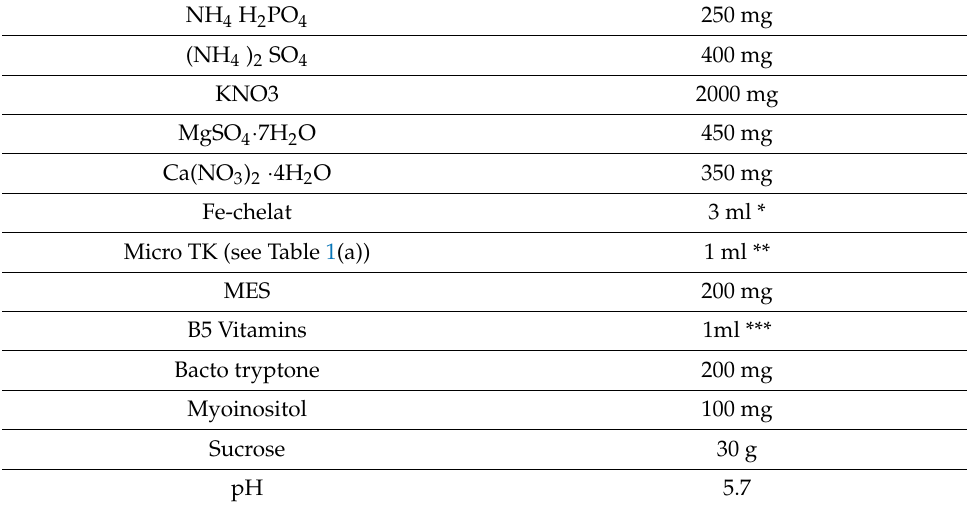
Figure 6. Cell proliferation from root-derived Arabidopsis protoplasts. ( A )—in enzyme solution; ( A1 )—in the medium after isolation; ( B ) — first cell division; ( C1 , C2 )—marker line H2B::YFP undergo mitosis. Scale bar— 20 µ m. Table 3. TK4 medium for plant regeneration for 1 L of